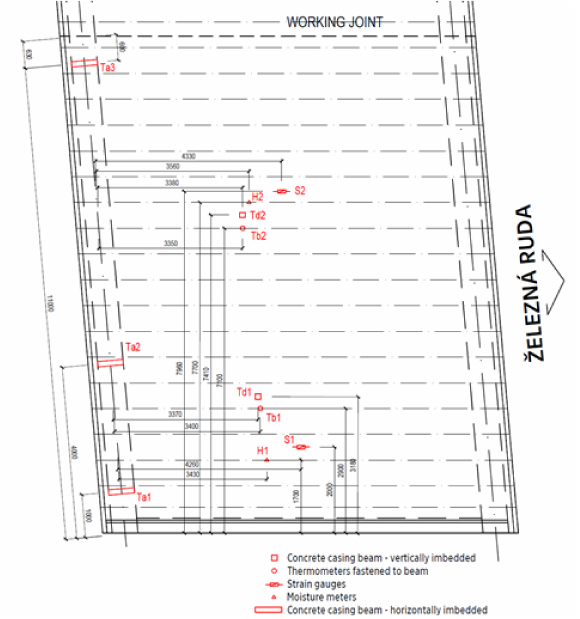
Figure 1. Deployment of all the measured spots in the ground plan of the bridge structure.